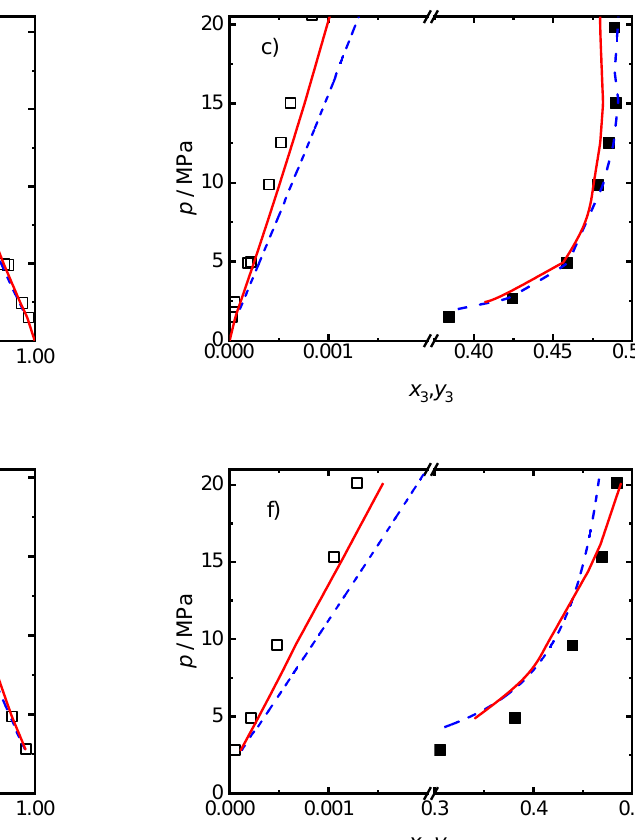
Figure 6. Vapour – liquid equilibrium for the (CO 2 (1) + H 2 O(2) +N 2 (3)) system at temperatures of ( a – c ) 323 K and ( d – f ) 373 K. Empty symbols represent dew points, and filled-in symbols represent bubble points. The mole ratio of CO 2 /N 2 fed to the system was 1. Continuous red lines represent the description of the γ - φ model, and dashed blue lines represent the description of the SAFT- γ Mie model.